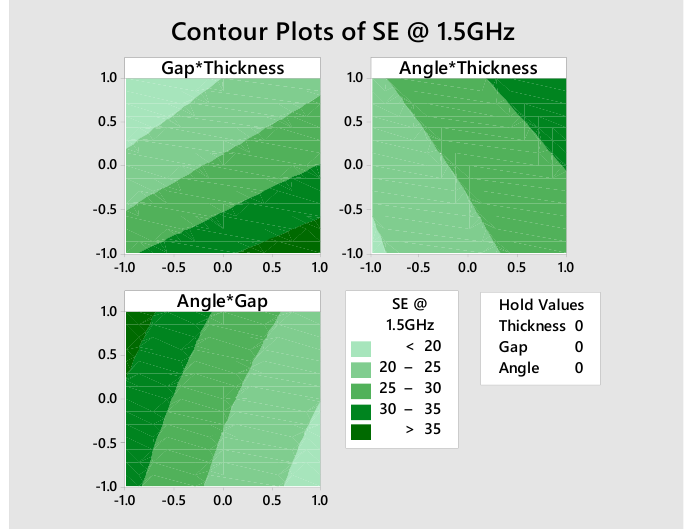
Figure 11. Contour plot showing the quantitative effect of gap and thickness; angle and thickness; angle and gap on SE (dB) at 1.5 GHz frequency.